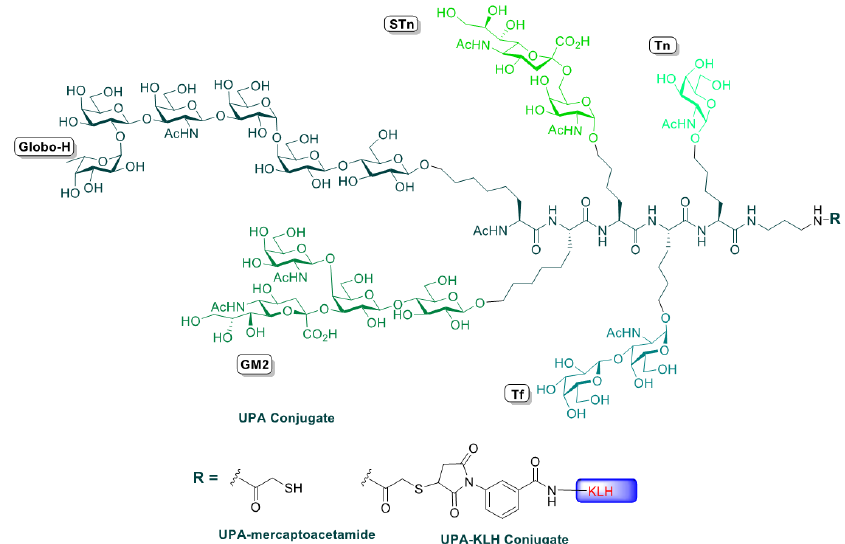
Figure 1. Unimolecular pentavalent vaccine.